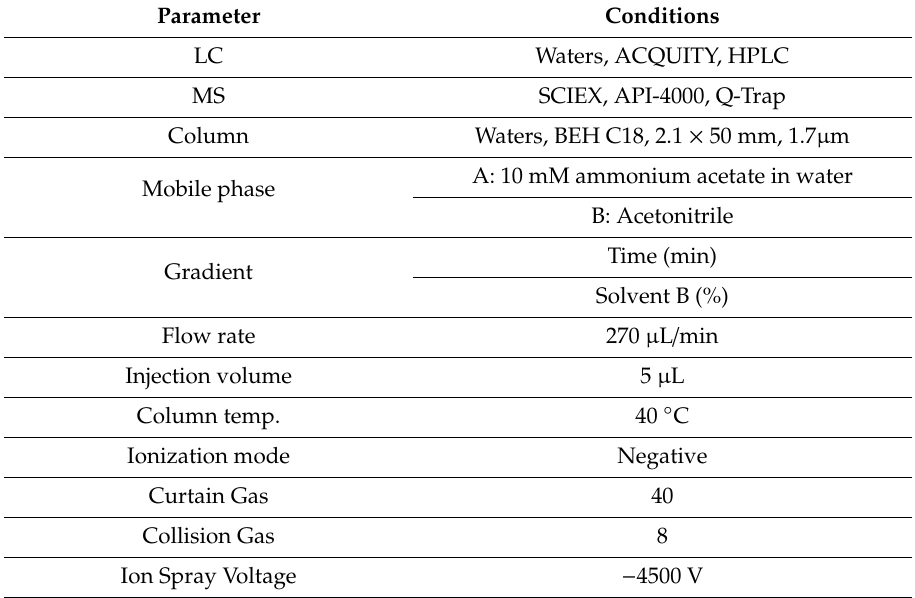
Table 1. Analytical condition of perfluorinated compounds (LC: Liquid chromatography; MS: mass